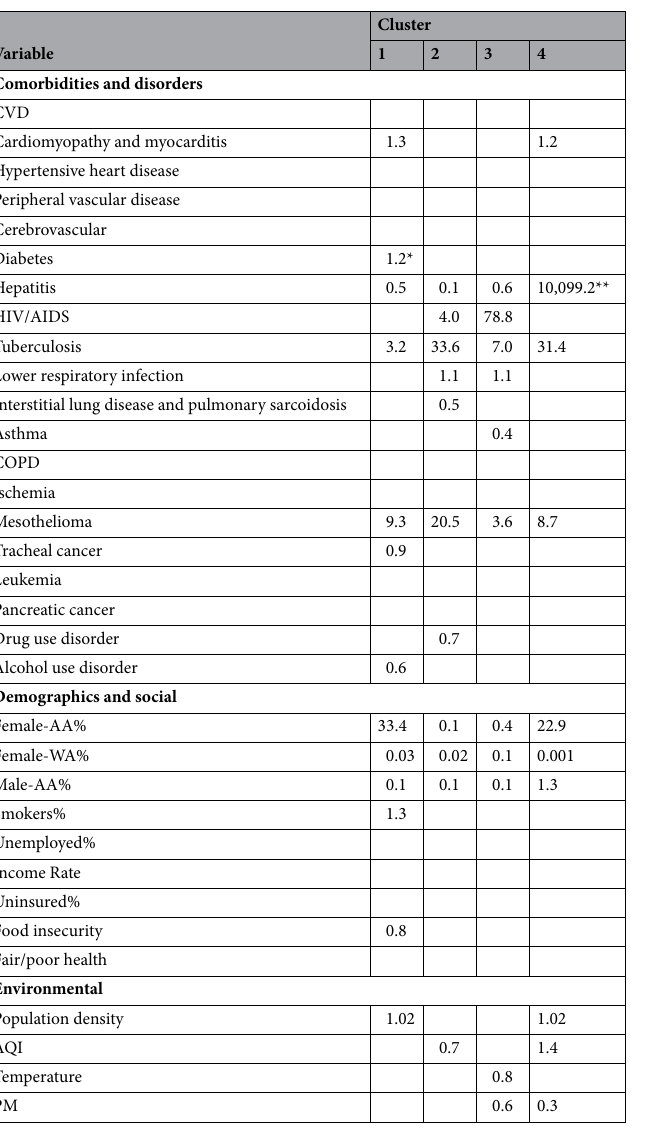
Table 7. 3rd Wave (Sep 3–Nov 12, 2020): significant risk factors and their odds ratios in each cluster compare to cluster 0 (counties with MIR = 0). Blank spots indicate the insignificant risk factors. *For instance, OR 1.2 means that 1% increase in diabetes MR is associated with a 20% increase in the relative log odds of being in cluster 1 vs. cluster 0 (MIR = 0). **Due to the sparsity of hepatitis mortality rate in these particular counties (during the 3rd wave), the odds ratio estimation of hepatitis is not reliable. One way around this issue is to categorize the hepatitis MR and use the categorical version of this variable in the multinomial model. However, we decided to avoide this approach to stay consistent with the rest of the